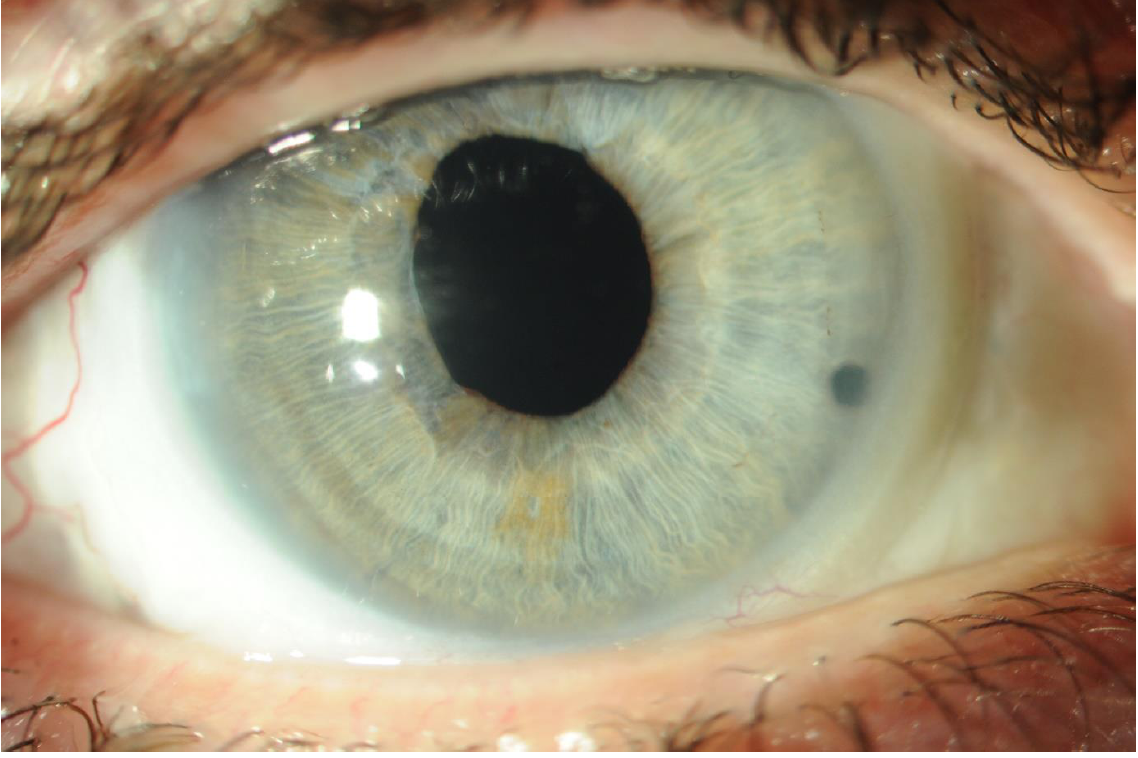
Right eye — anterior segment at 1 month of SSF IOL implantation. Figure 3. Right eye—anterior segment at 1 month of SSF IOL